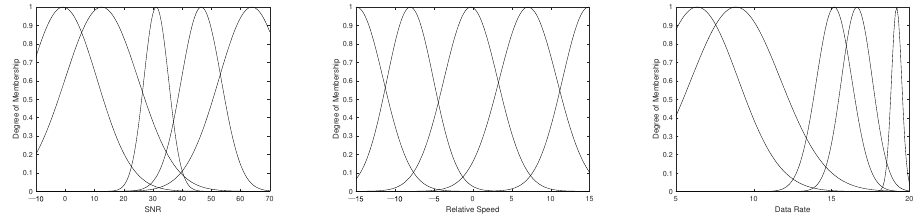
Figure 4. Input membership